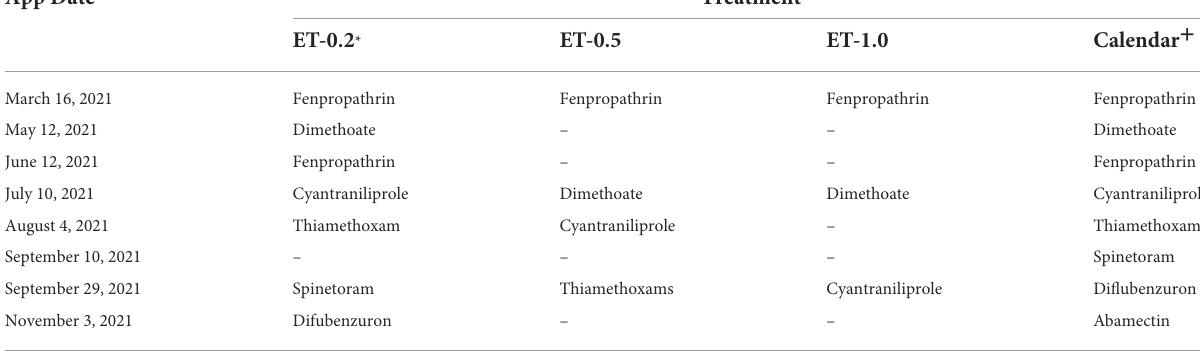
TABLE 2 Description of the insecticide rotations used in the economic threshold (ET) treatments evaluated for management of Diaphorina citri in the